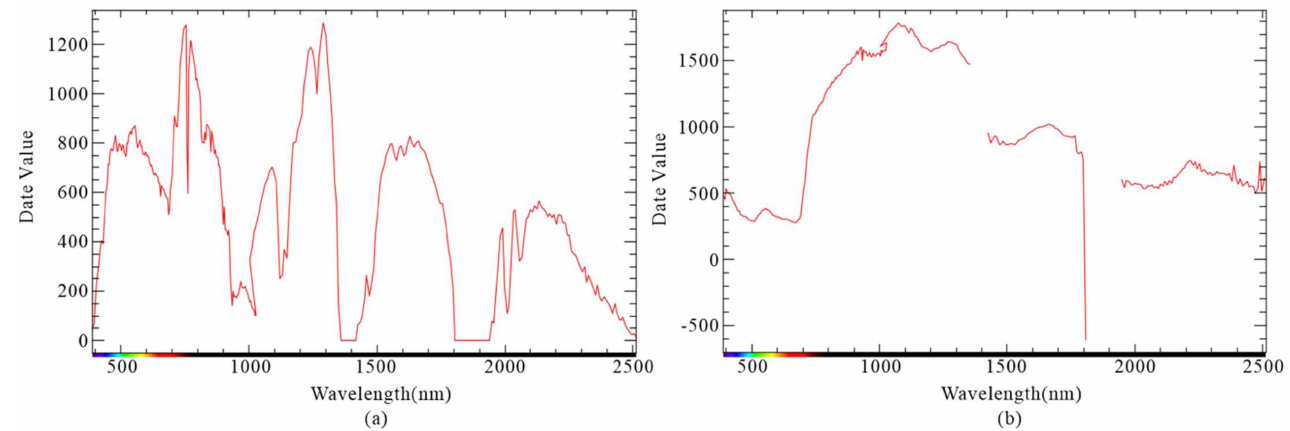
Figure 6. ( a ) Raw GF-5 spectral profile; ( b ): GF-5 spectral profile after radiometric calibration and